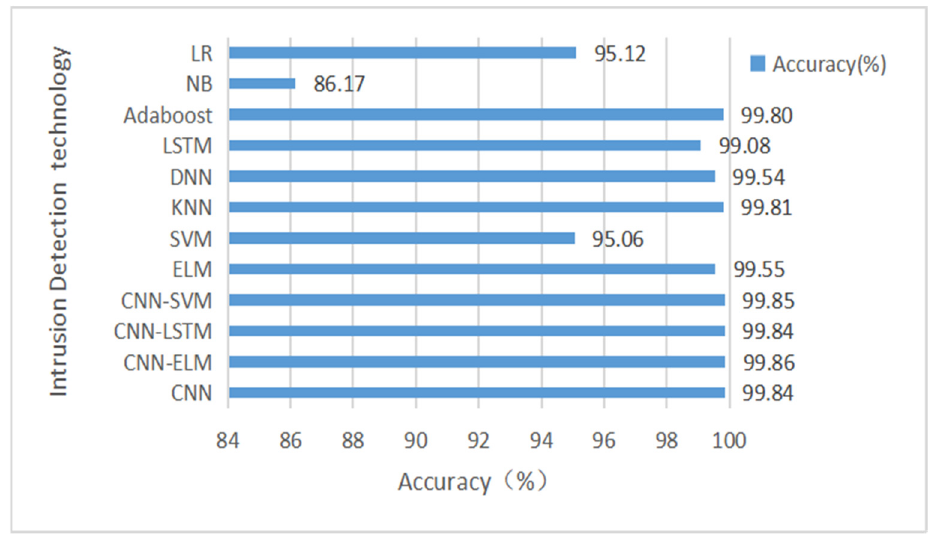
Figure 8. The accuracy comparison of CNN-ELM hybrid model based on the results of 48 subsets of features in the CIC-IDS 2017 dataset